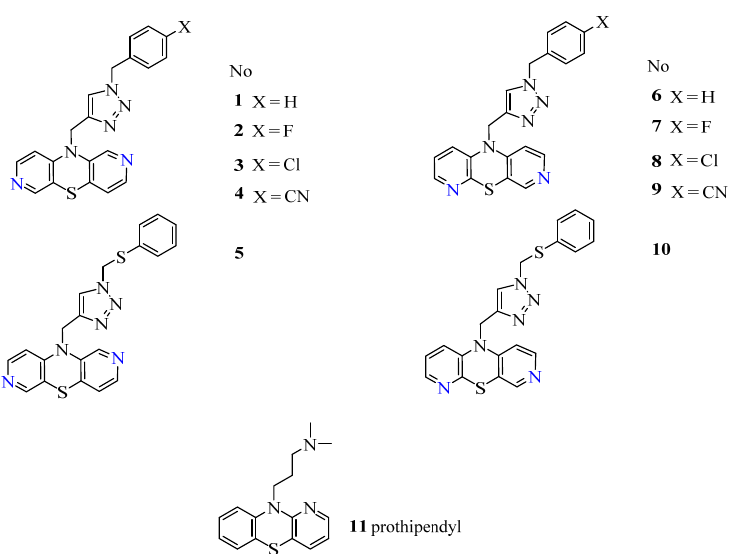
Figure 2. Structure of 1,2,3-triazole-dipyridothiazine hybrids (1–10) and prothipendyl (11).